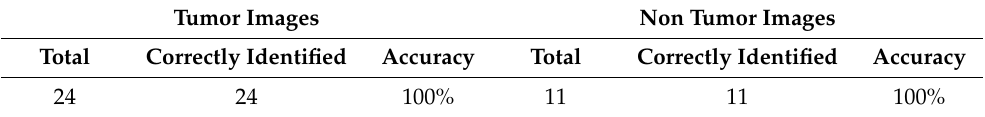
Table 2. Algorithmic accuracy of the system.